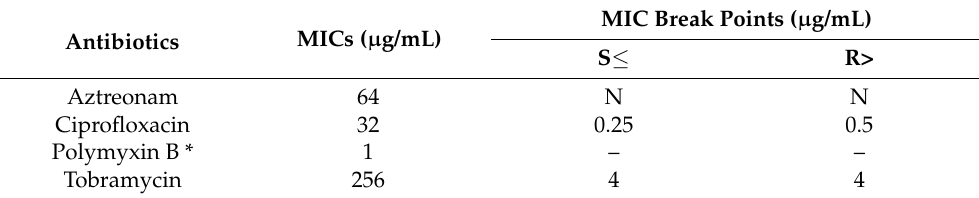
Table 1. Minimum inhibitory concentrations (MICs) of different antibiotic against A. baumannii K31. Antibiotics MICs ( µ